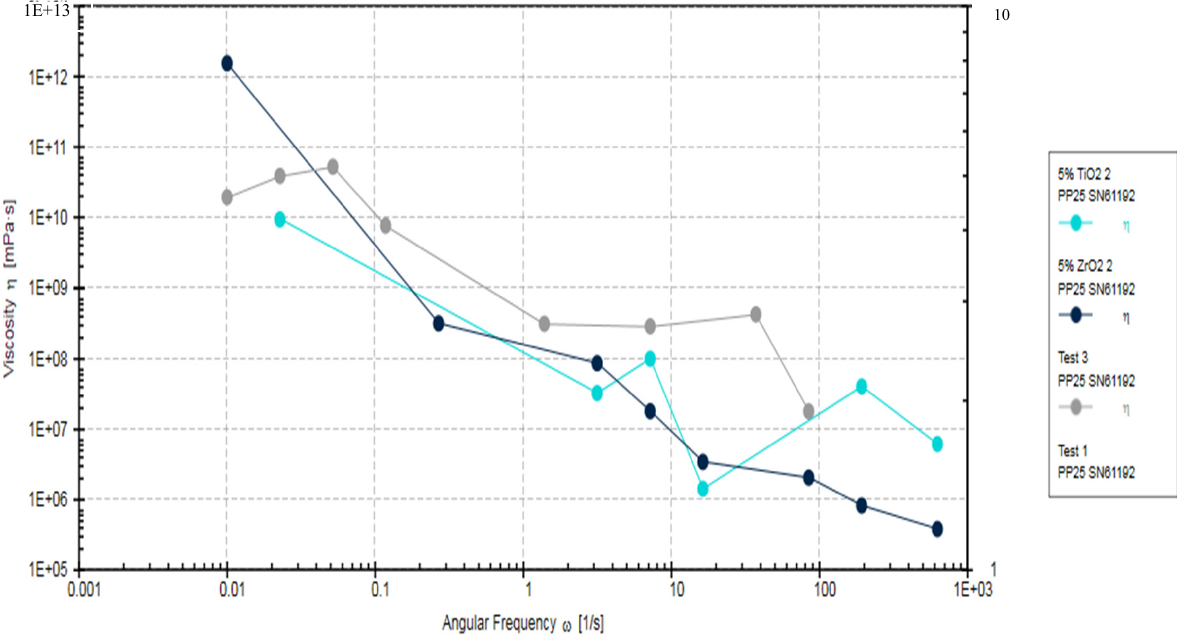
Figure 5. Rheometric properties of EA, 5% TiO 2 and 5% ZrO 2 adhesives, showing complex viscosity of angular frequencies of 0.001 to 1000 rads/s.